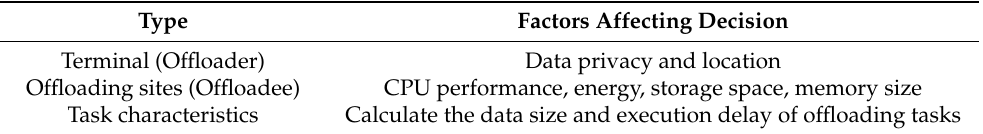
Table 1. Factors Affecting Computation Task Offloading Decisions.